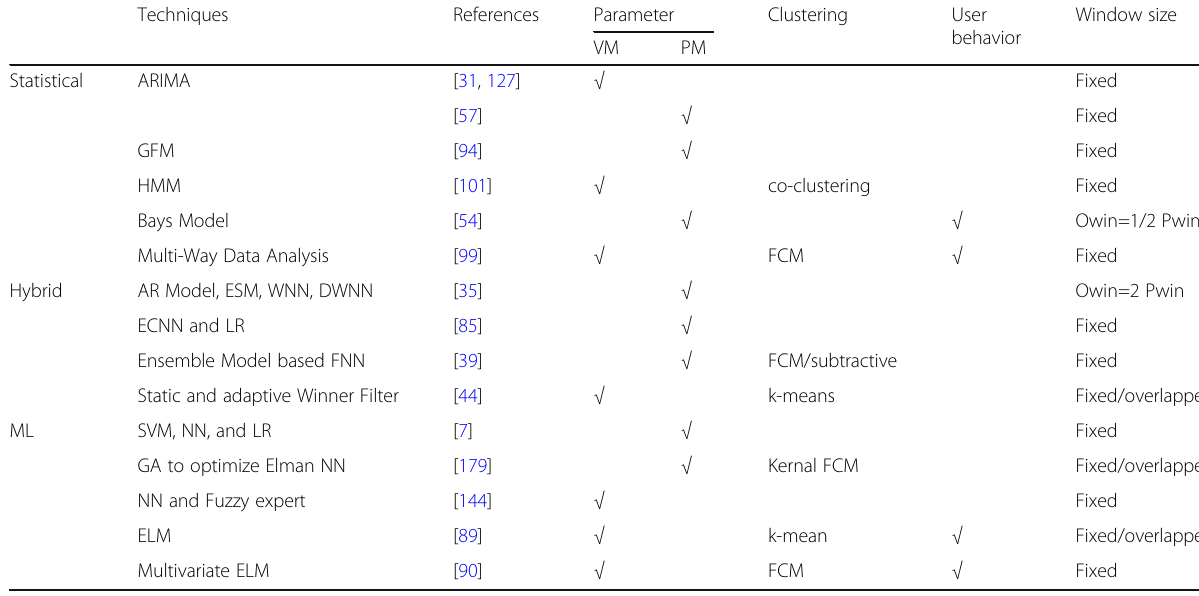
Table 1 Workload prediction techniques